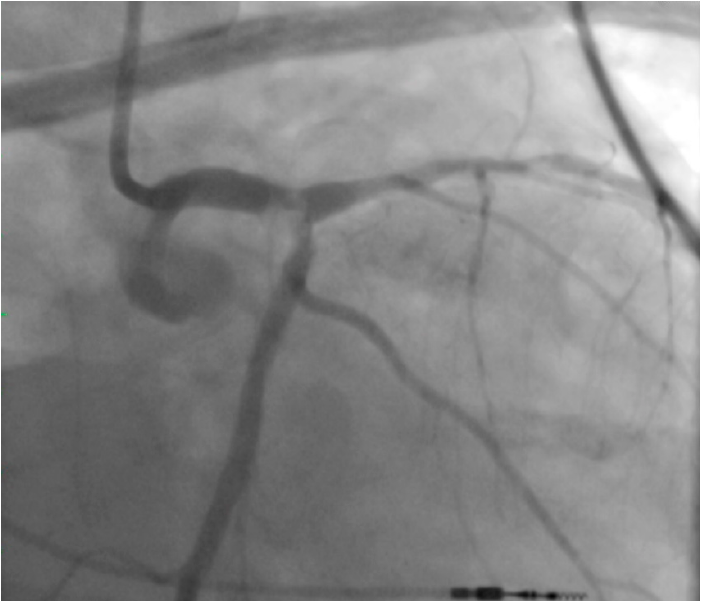
Figure 1. Pre-Intervention Coronary Angiogram. There is evidence of a calcific 80% distal left main coronary artery lesion that extends to the left anterior descending and left circumflex arteries (Medina 1.1.1).